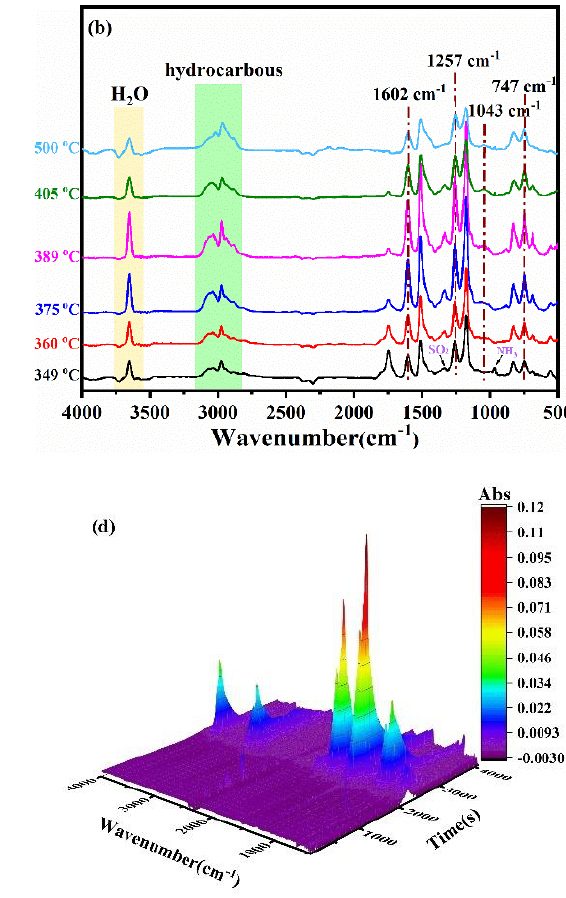
Figure 10. TG-FTIR spectra at different temperatures, EP ( a ) and FREP-7.5 ( b ) 3D TG-FTIR spectra of pyrolysis products for EP ( c ) and FREP-7.5 ( d ).